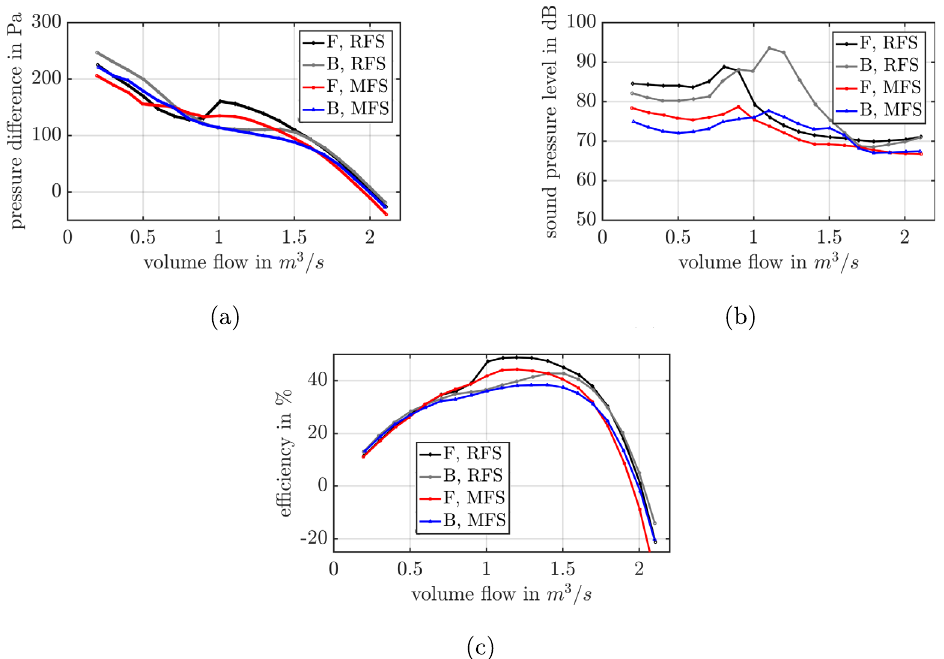
Figure 14. Fan characteristic curves for short MaPA (MFS setup). (a) Pressure rise. (b) Sound pressure level. (c) Ef fi ciency.